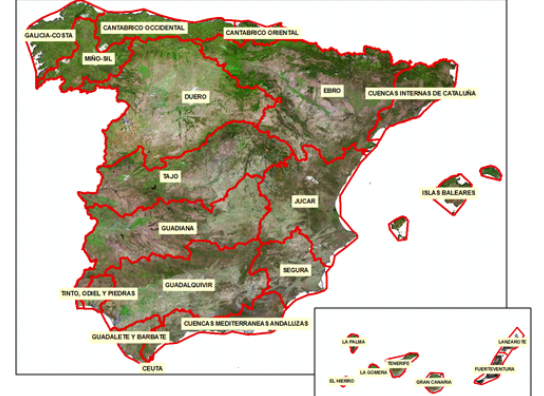
Figure 16. River basin district in Spain: areas of production management (at bottom right is Canarias in fictitious location)